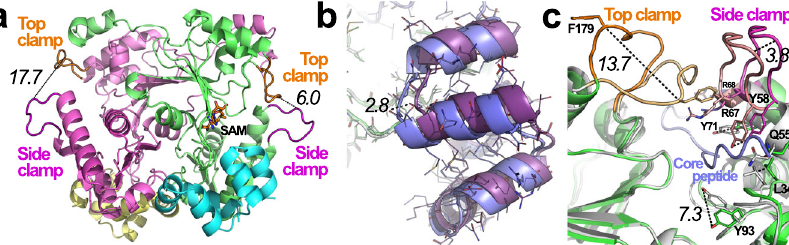
Fig. 5 SonM — SonA-BBD — (±)SAM structure showcases closed and open conformations. a One SonM — SonA-BBD heterodimer (green and cyan cartoon, right) has SAM bound (orange sticks) in the active site with the top and side clamps in a previously seen closed conformation. The other SonM — SonA-BBD heterodimer (magenta and yellow cartoon, left) lacks a bound cofactor and display an open conformation for both top and side clamps. b Structural overlays of the BBDs from the apo SonM — SonA-2Me complex (slate cartoon) and the heterodimer in the open conformation for the SonM — SonA-BBD — (±)SAM complex (purple cartoon). The BBDs bind similarly but appear to be translated from each other. c Structural overlays of the active sites from the apo SonM — SonA-2Me complex (white and slate cartoon) and the heterodimer in the open conformation for the SonM — SonA-BBD — (±)SAM complex (green cartoon). Loop differences and residue shifts (sticks) are highlighted. Key distances are depicted as black dashed lines and their lengths noted in italics in Ångstroms. We note that crystal contacts may contribute to the con fi guration of the open form of the top clamp. However, the observation of both open and closed forms of the top clamp within the same crystal strongly suggests the two conformations precede crystal